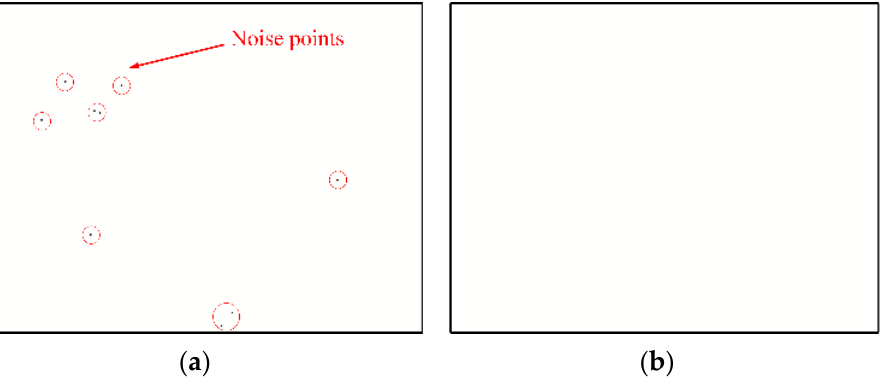
Figure 5. Results of nearest neighbor filter. ( a ) Before filtering, ( b ) After filtering.